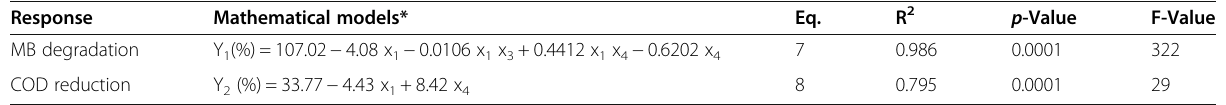
Table 3 Mathematical models obtained using Statgraphics Centurion XV.2 software for the studied responses. All data had a confidence level of over 95.0%